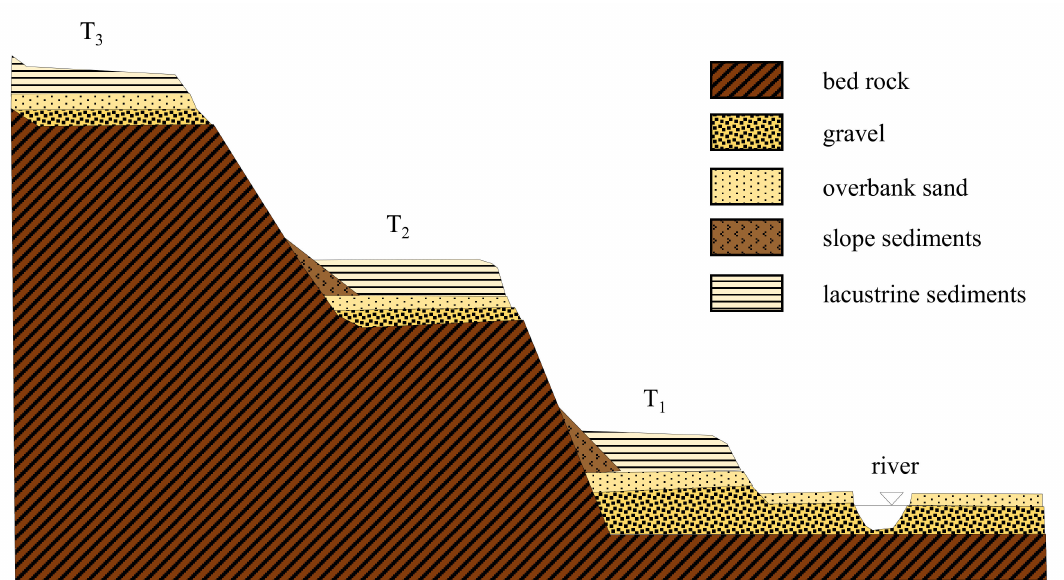
Figure 7. Diagrammatic drawing of river geomorphology.